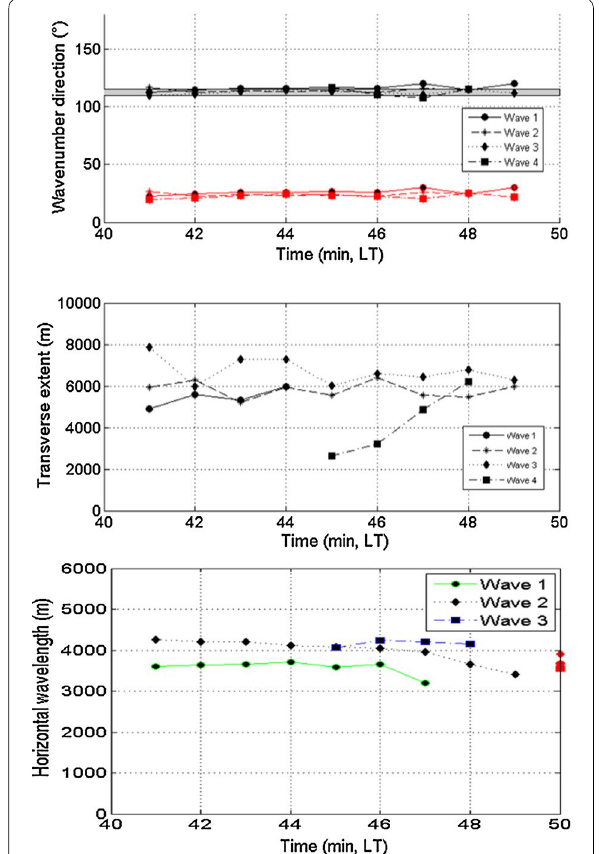
Fig. 13 Variation in KH billow properties with time according to the fish-eye camera images. The gray area in the top panel shows the wind shear direction according to the MU radar data. The red lines show the direction of the billow axes. The red dots in the bottom panel show the horizontal spacing of the KH billows from radar